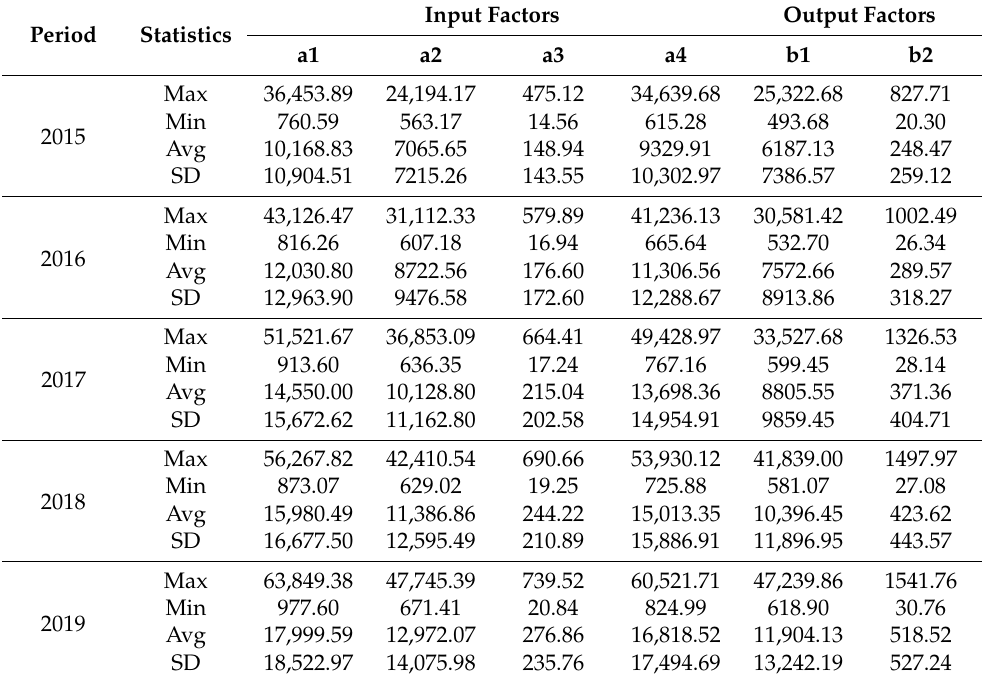
Table 3. Statistical analysis for each year.